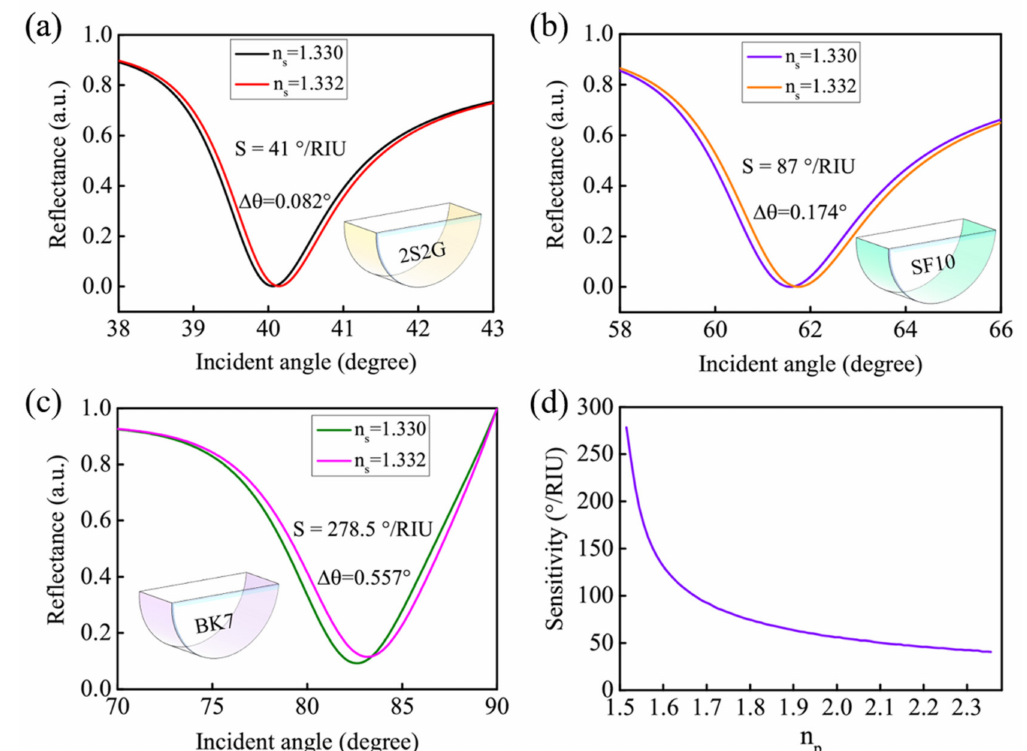
Figure 4. ( a – c ) The GWSPR signals excited from the prisms of 2S2G, SF10, and BK7 when ∆ n s = 0.002. The sensitivity is calculated to be 41 ◦ /RIU, 87 ◦ /RIU, and 278.5 ◦ /RIU for the 2S2G, SF10, and BK7 prisms, respectively. ( d ) The specific change of sensitivity with respect to the n p